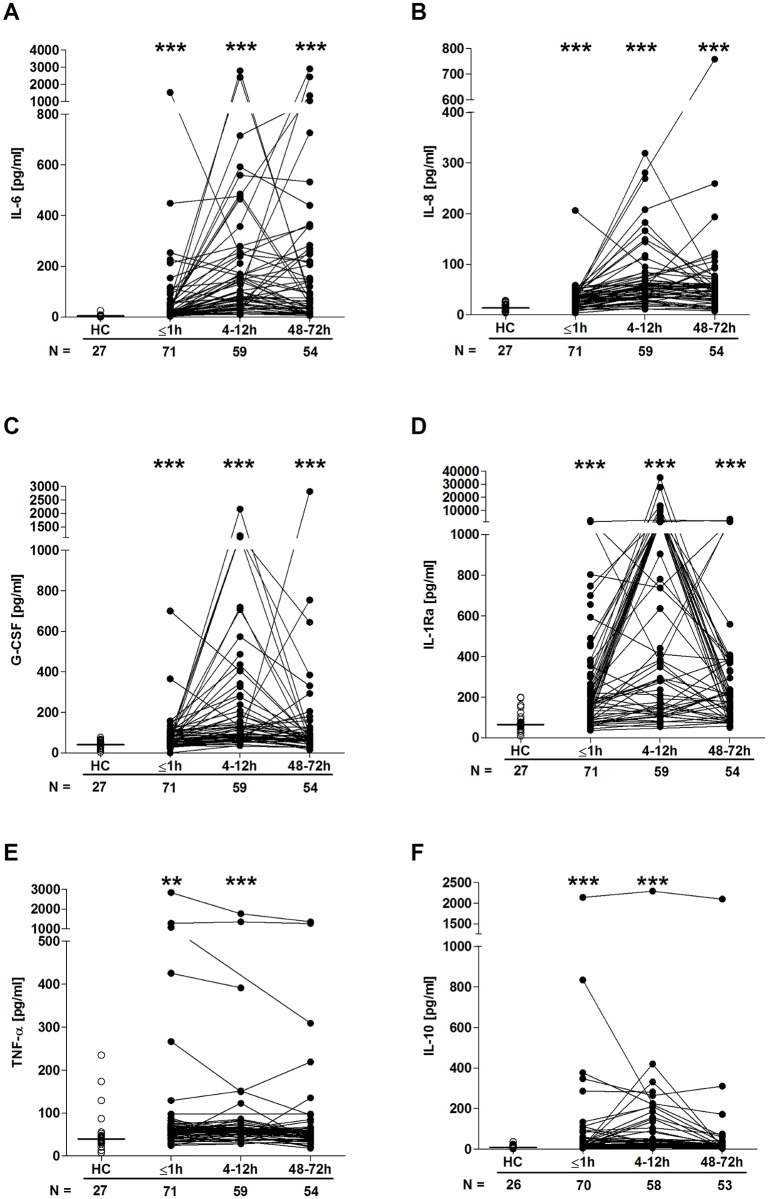
Serum cytokine and chemokine concentrations post-trauma.Serum concentrations of IL-6 (A), IL-8 (B), G-CSF (C), IL-1Ra (D), TNF-α (E), and IL-10 (F) across time post-trauma. The number of patient and HC samples analysed is indicated below each time point. The horizontal line for HC data depicts the median value. **p < 0.005, ***p < 0.0005 versus HCs. G-CSF, granulocyte-colony stimulating factor; HC, healthy control; IL, interleukin; IL-1Ra, interleukin-1 receptor antagonist; TNF- α, tumour necrosis factor-alpha.